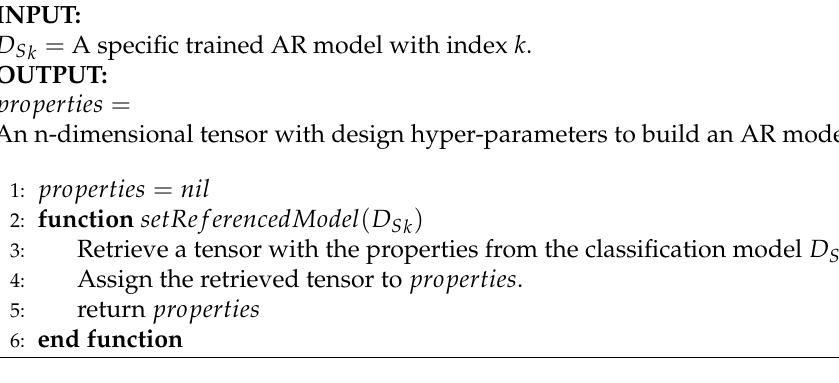
Algorithm 4 Selection of hyper-parameters from a given AR model.